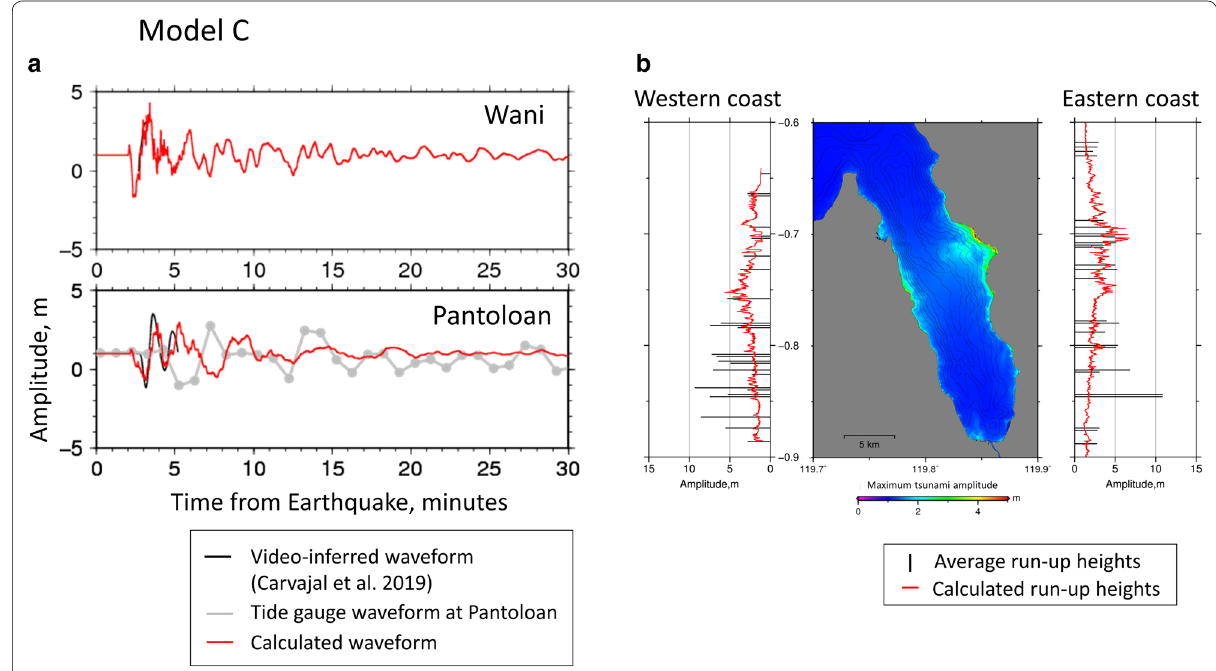
Fig. 5 Calculated tsunamis generated by the landslide source in the northern part of the bay (model C). Same as Fig. 4 for source model